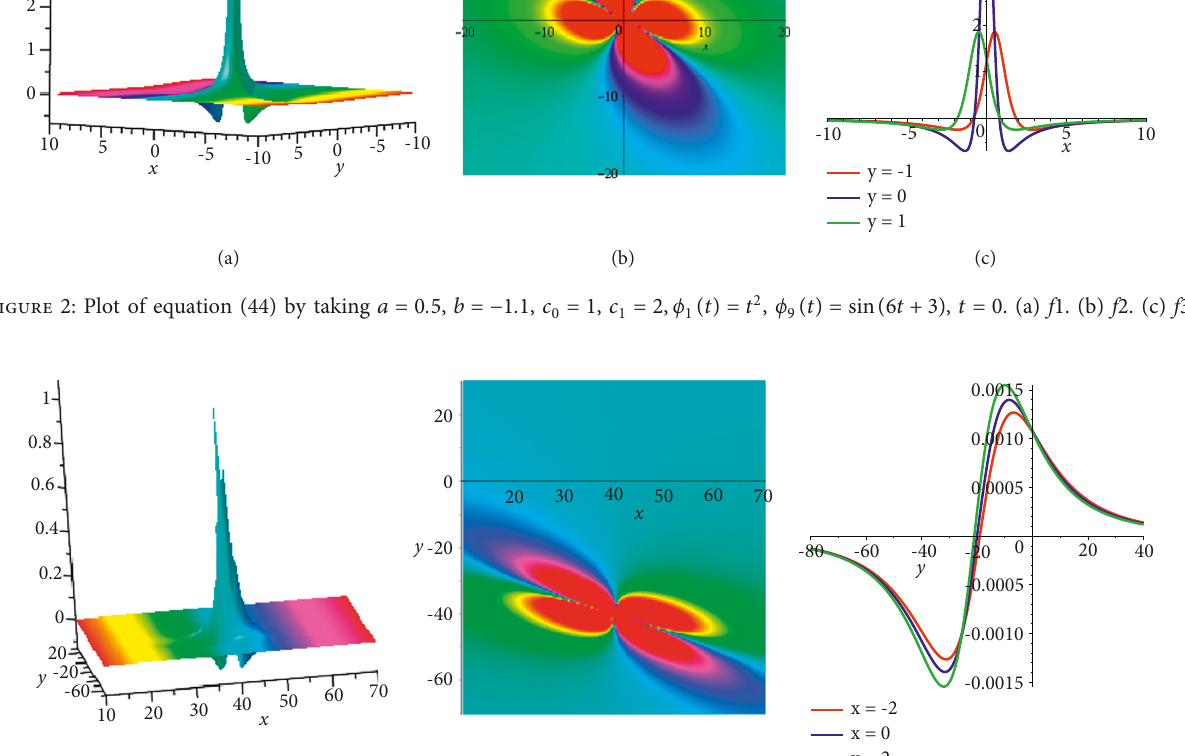
� 1 , c � 2 , ϕ ( t ) � t 2 , ϕ ( t ) � cos ( t ) , t � 1. (a) f 1. (b) f 2. (c) f 0 1 1 9